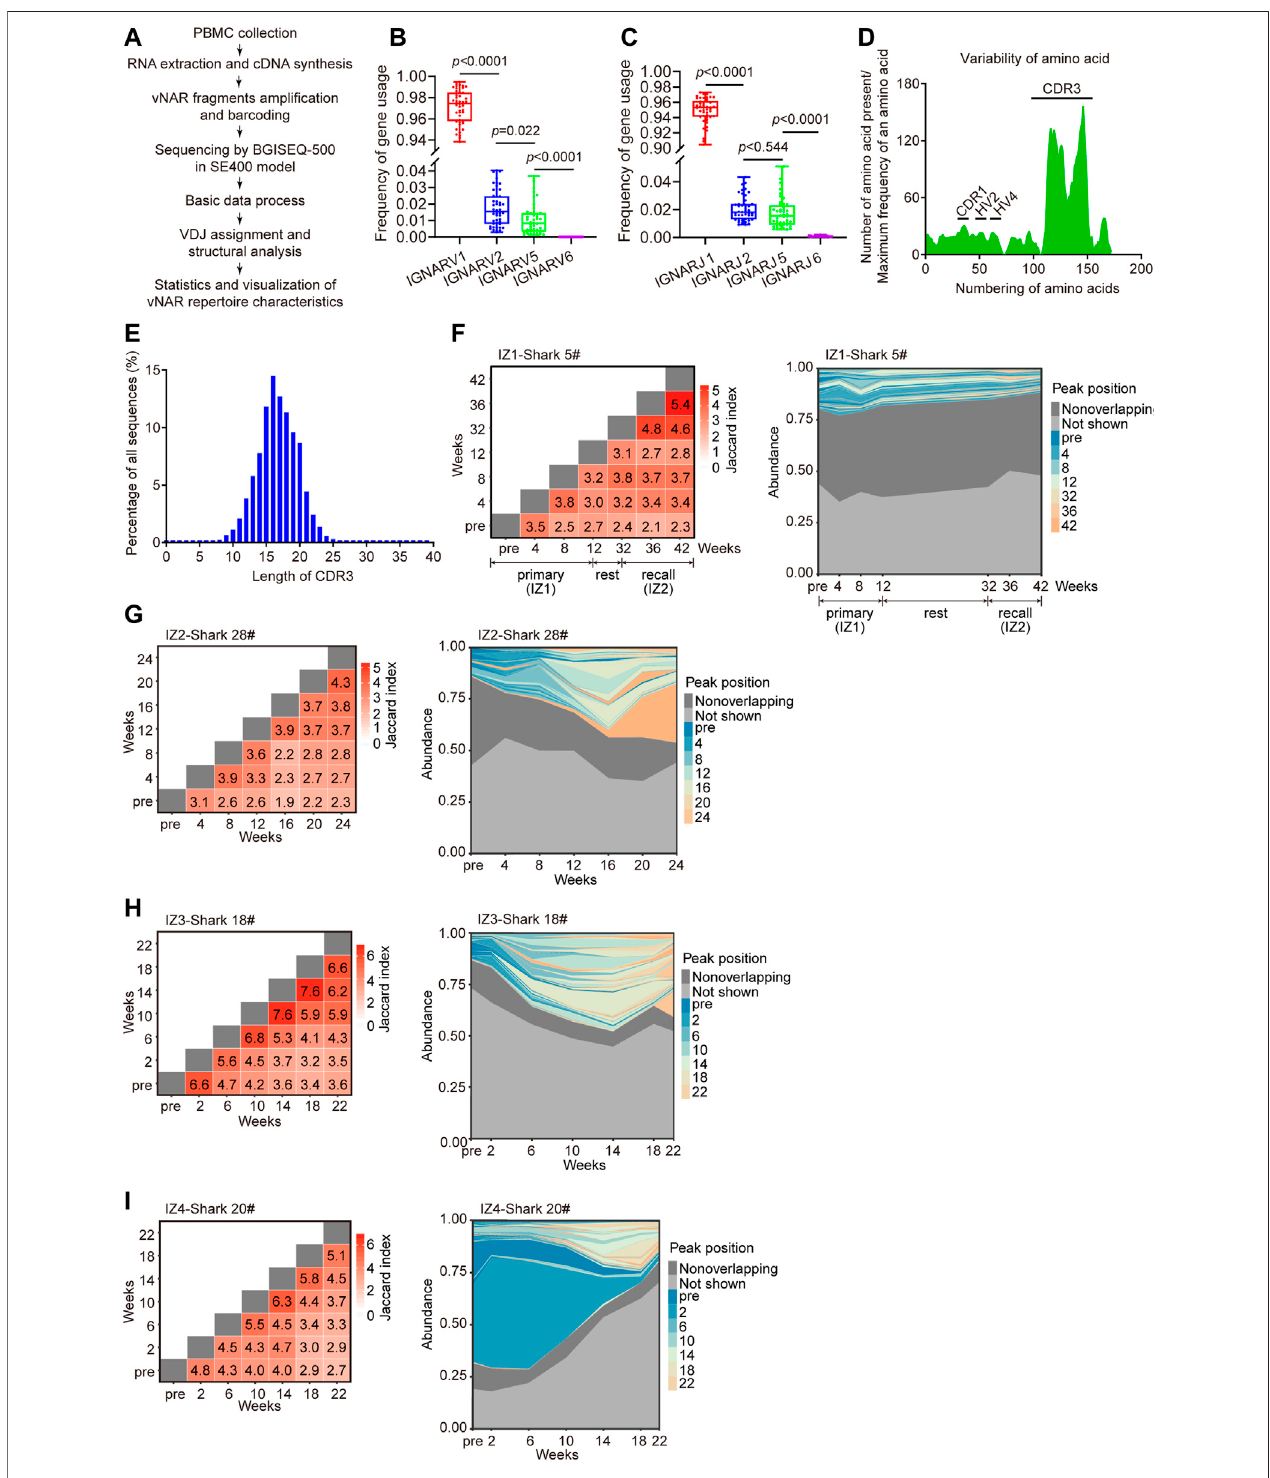
FIGURE 3 | Development of vNAR immune repertoire of bamboo sharks during immunization. (A) Schematic for the characterization of vNAR immune repertoire constructedfromimmunizedsharks. (B,C) UsagefrequencyofV/JgenesfromfourIgNARclusters.Statisticalsigni fi canceisindicatedbythe p value. (D,E) Variabilityof aminoacid sequences (D) and CDR3 lengths (E) ofvNARs ( n (cid:1) 3,00,000).CDR, complementarity determiningregion; HV,hypervariableregion. (F, I) Clonotype overlap andclonotypetrackingofvNARimmunerepertoireofbamboosharksduringimmunization.Peakpositionsrepresenttheabundancepro fi lesoftop100clonotypes (colored), non-overlapping clonotypes (dark gray), and remaining (Not shown)clonotypes (lightgray).Value in each tileofheatmaprepresentsthe clonotype overlap rate between two time points as shown on the two axes.